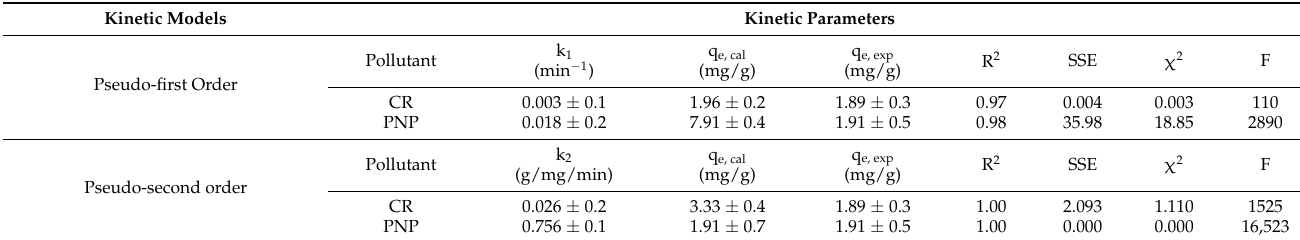
Table 7. Kinetics and statistical data of pseudo-first and second-order kinetic models for photodegradation of CR and PNP onto CaFe 2 O 4 -NGO.